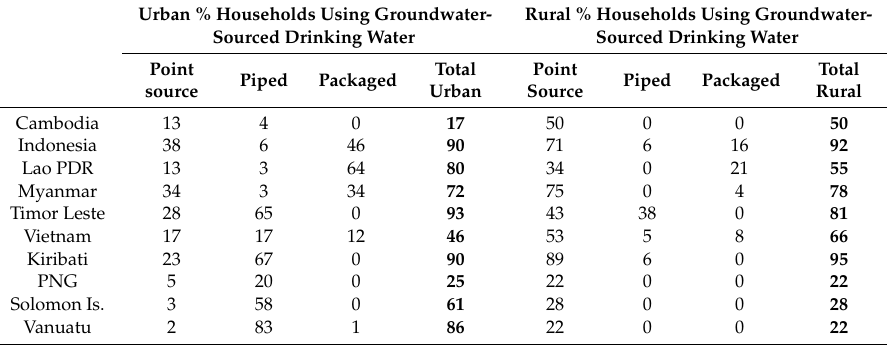
Table 1. Proportion of households using point-source, piped and packaged water sourced from groundwater in urban and rural